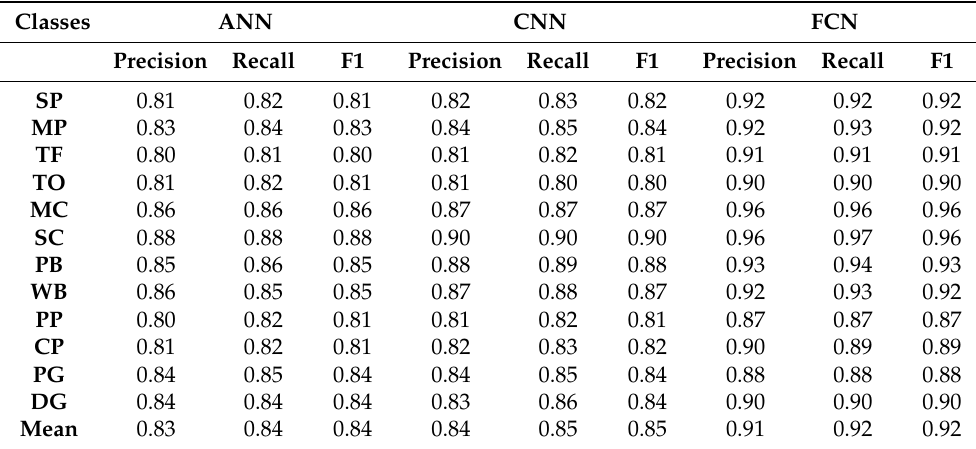
Table 9. Comparison with well-known classifiers in terms of precision, recall, and F1 measure over SYSU HOI 3D dataset.